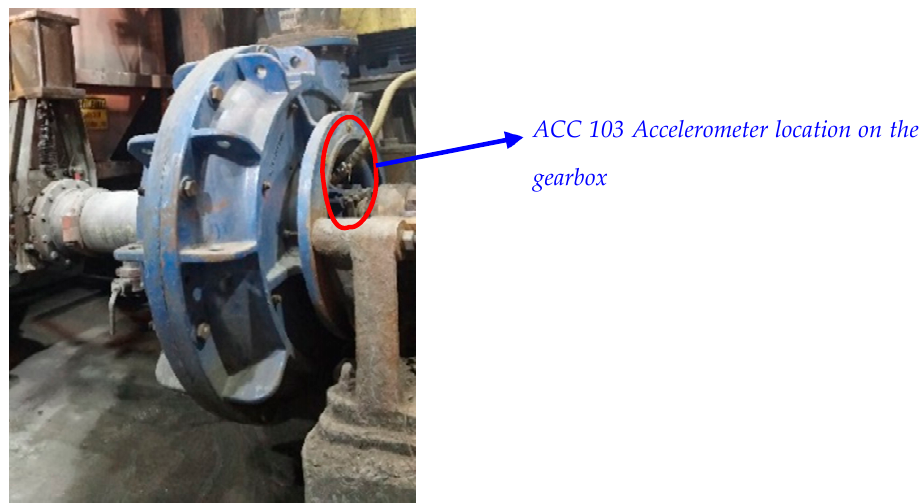
Figure 4. Accelerometers location on the gearbox.